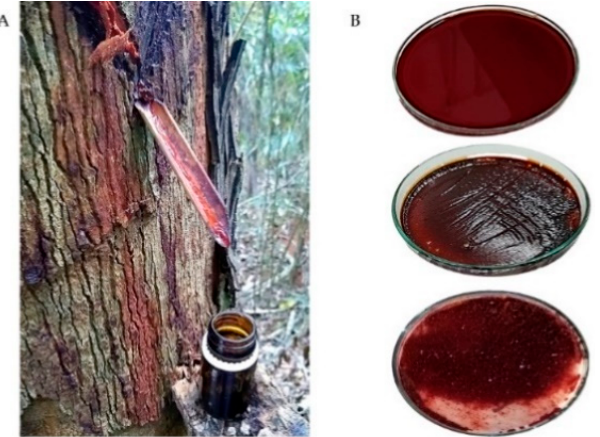
Figure 1. Extraction of Virola oleifera resin. After 0.5 cm deep incisions were made in the tree trunk, the fluid was collected in an amber glass bottle, as showed in ( A ). The fluid exudate was dried (45 ◦ C for 72), then granulated, until obtaining the dry resin, as seen in ( B